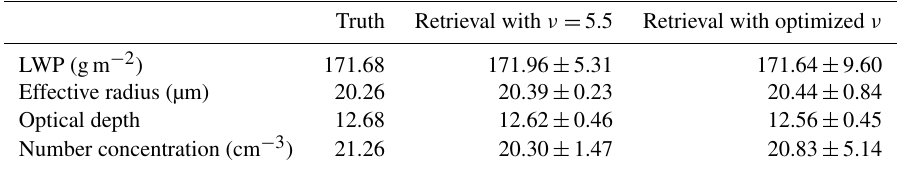
Figure 3. Synthetic signals generated using ECSIM based on LES. Panels (a) – (d) compare radar reflectivity Z and lidar attenuated backscat- ter β between the synthetic signals that are fed to the retrieval as input (a, c) and best fit produced by the retrieval (b, d) . Panels (e) and (f) : histograms of the differences between the true and the retrieved signals (truth minus retrieval). The spread of the distribution is indicated by the blue vertical lines that mark the interval within which 95% of the total occurrences are found. The red curves show the cumulative distributions. Panel (g) shows brightness temperatures T B averaged over distance at each frequency channel: the black circles and line show the synthetic measurements (data mean) while the dashed red line shows the retrieval mean. In (h) we plot the standard deviation of the data mean (black line in g ) divided by the data mean itself (black) and the RMSD between the retrieval and the data divided by the data mean (red). Table 2. Values of the LWP, r e , optical depth, and the number concentration (as shown in Fig. 5), averaged over the horizontal distance. The RMSD between the truth and the retrieved values is given as the error of the retrievals. The last column is given here for completeness – see discussion in the